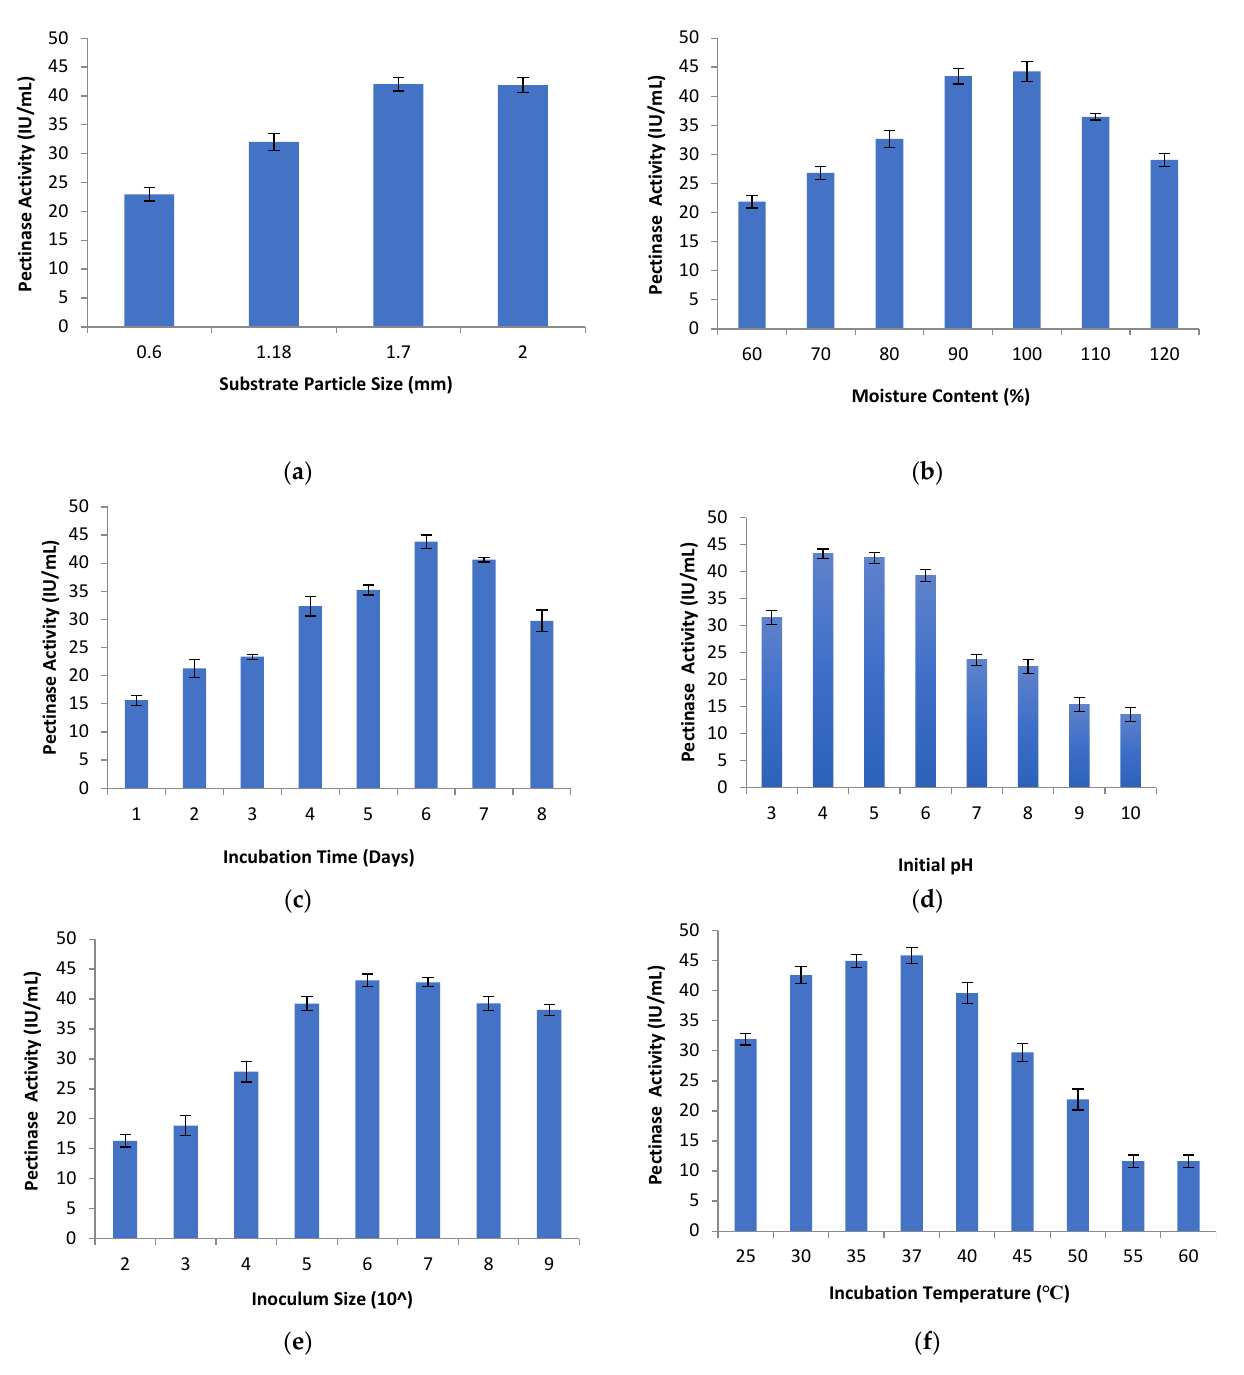
Figure 2. Pectinase activity for different ( a ) substrate particle sizes, ( b ) moisture content, ( c ) incubation time, ( d ) initial pH, ( e ) inoculum sizes, ( f ) incubation temperatures.